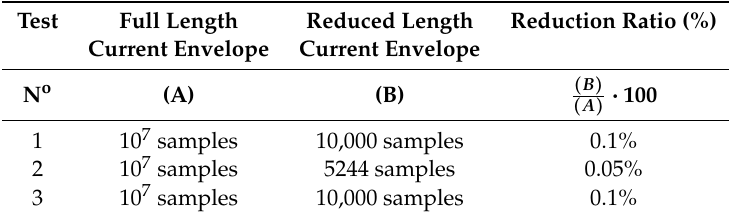
Table 2. Comparison between the number of current samples of the full-length current envelope and of the reduced current envelope proposed in this